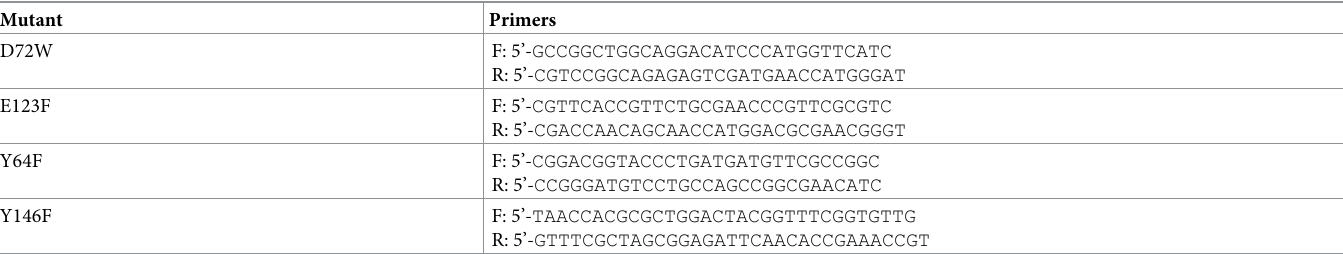
Table 1. Primers used to generate AAC(3)-IIIa mutants.